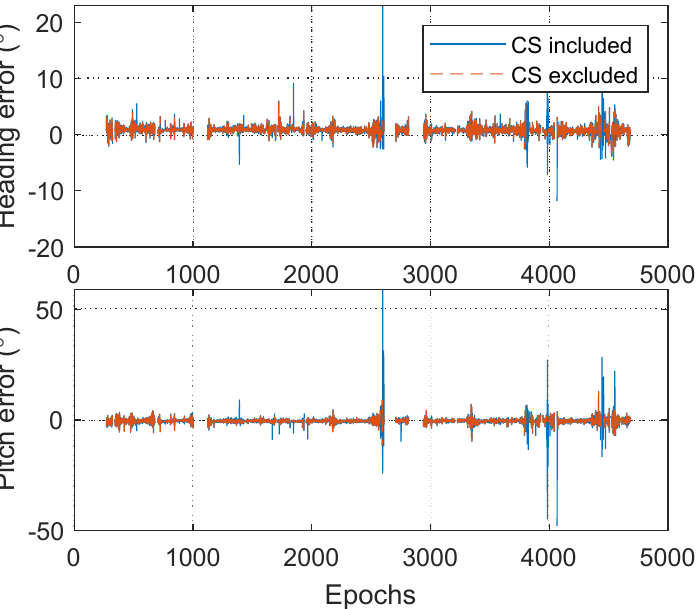
Figure 15. Influence of cycle slips on the vehicular heading and pitch errors with the TDCP-based algorithm. Table 4. RMS, absolute maximum error, and solution availability of heading and pitch estimates from TDCP with and without cycle slips.